Question: What type of chart is this?
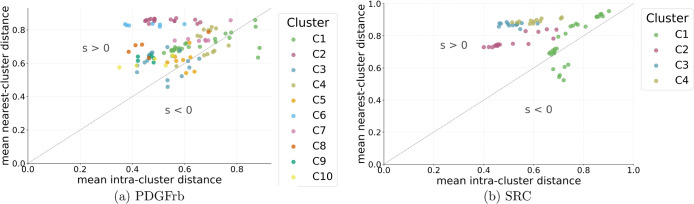
Answer: scatter